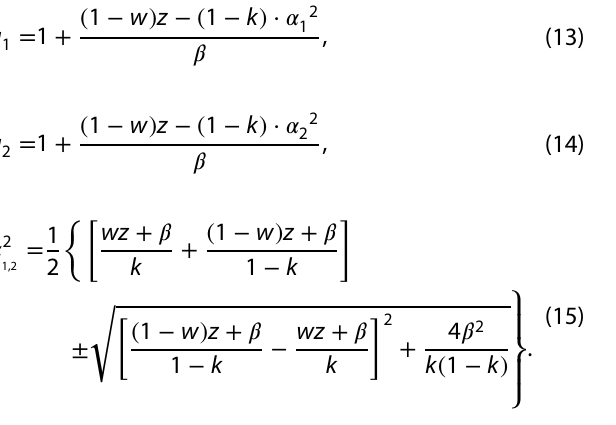
Fig. 2 Effect of 𝜀 P